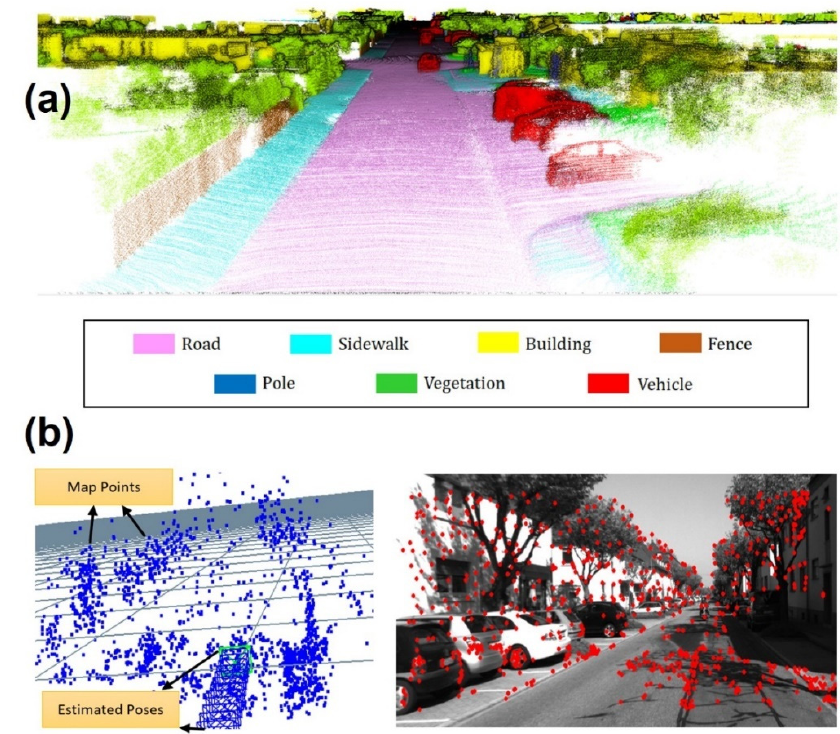
Figure 9. ( a ) Generated three-dimensional map for navigation [138]; ( b ) Visual odometry in an autonomous car (red dots for map points) [139].